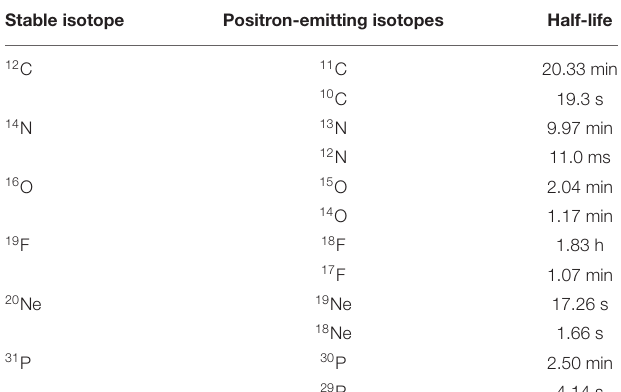
TABLE 1 | Positron-emitting isotopes that are found in proton therapy by target fragmentation and/or that have been considered as projectiles for RIB therapy. Stable isotope